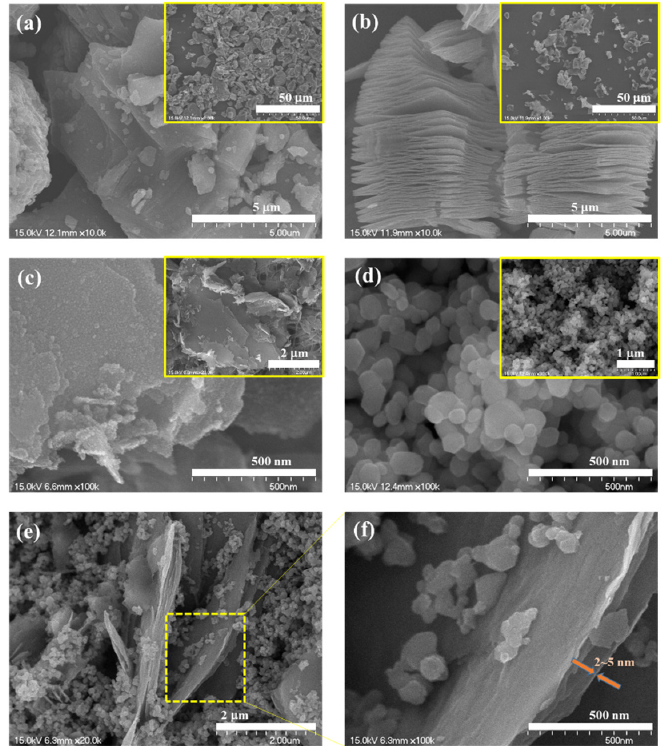
Figure 2. SEM images of ( a ) Ti 3 AlC 2 MAX phase, ( b ) Ti 3 C 2 T x MXene multilayer, ( c ) Ti 3 C 2 T x MXene few-layer, ( d ) pure ZnO nanoparticles, and ( e , f ) ZnO/Ti 3 C 2 T x hybrid structure. The insets show low-magnification SEM images.